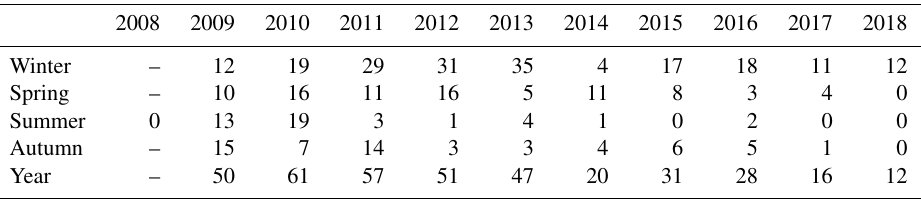
Table 2. Number of days exceeding 25µgm − 3 for PM 2 . 5 concentrations (WHO recommendation) since they are measured in MRS-LCP. Results are presented by season and for the total